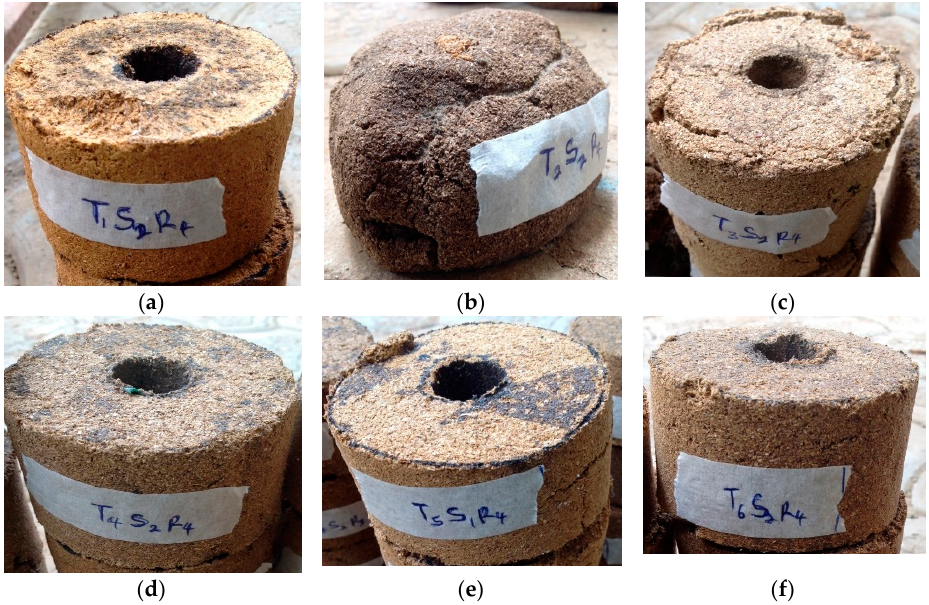
Figure 3. Briquettes produced from different particle types. ( a ) Anogeissus leiocarpus briquette (T1); ( b ) Groundnut Shell briquette (T2); ( c ) Corn Cobs briquette (T3); ( d ) Mixture of T1 + T2 briquette; ( e ) Mixture of T1 + T3 briquette; ( f ) Mixture of T1 + T2 + T3 briquette.